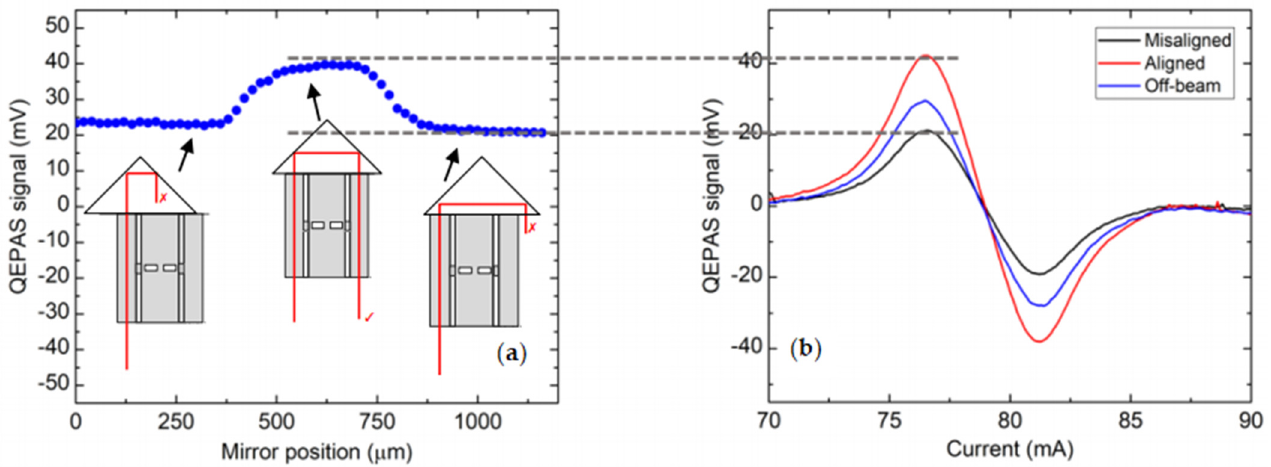
Figure 7. ( a ) Effect of the mirror position on the QEPAS signal maximum. ( b ) QEPAS signal versus laser current when the beam is misaligned ( black ) or aligned ( red ) with the mR 2, and comparing it with the results from conventional off- beam ( blue ).